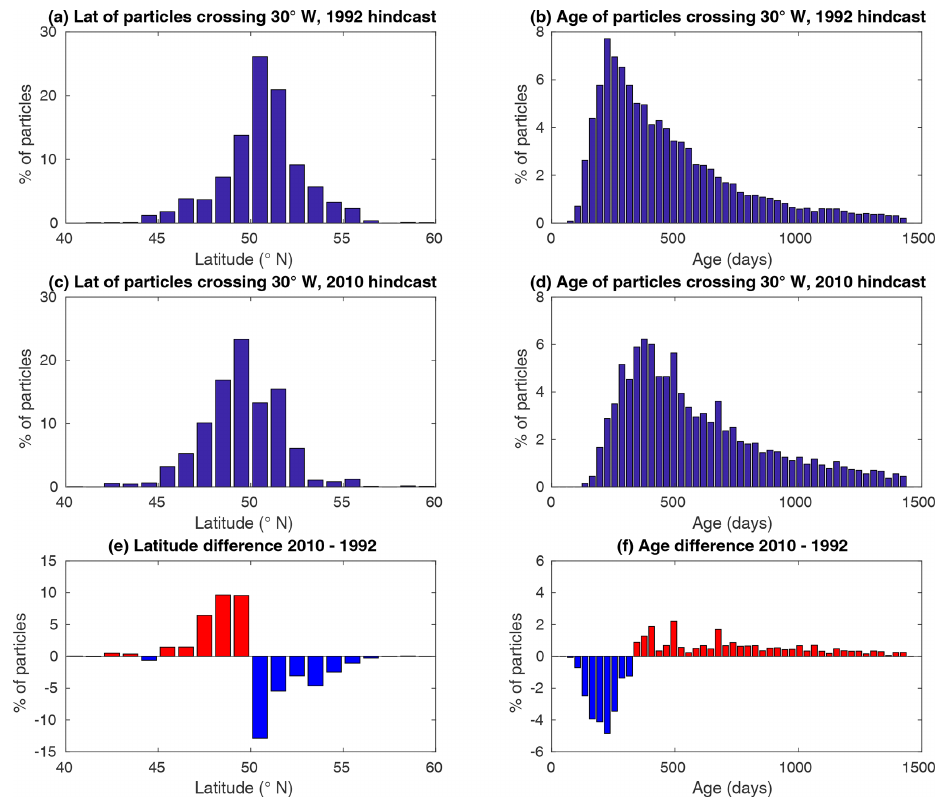
Figure 12. Histograms from the 1992 and 2010 hindcast showing the latitude and age of unique particles crossing 30 ◦ W for the first time (any further crossings are ignored): (a) 1992 particle latitude; (b) 1992 particle age; (c) 2010 particle latitude; (d) 2010 particle age; (e) latitude difference; (f) age difference. Positive difference means more particles in 2010. Data binned by 1 ◦ latitude and